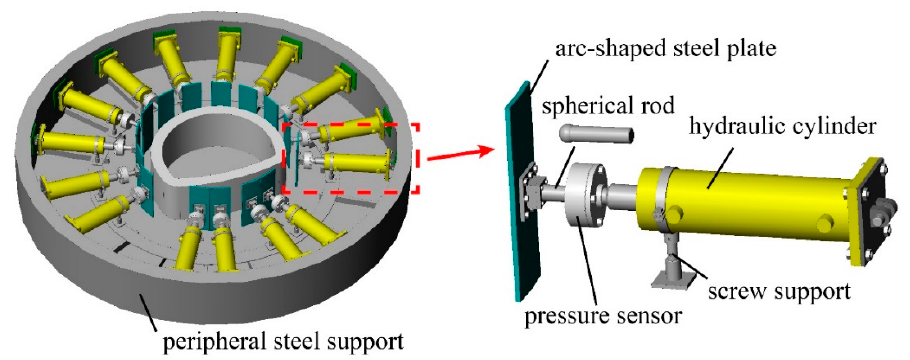
Figure 11. Loading system design.